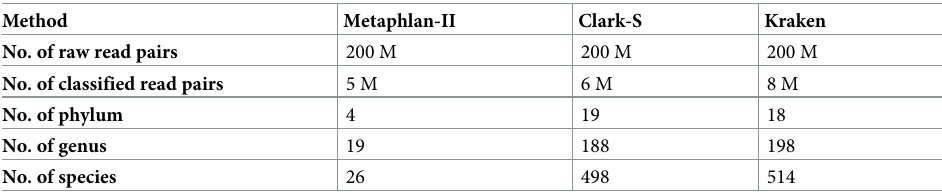
Table 2. Summary of read pairs used and prediction results using consensus